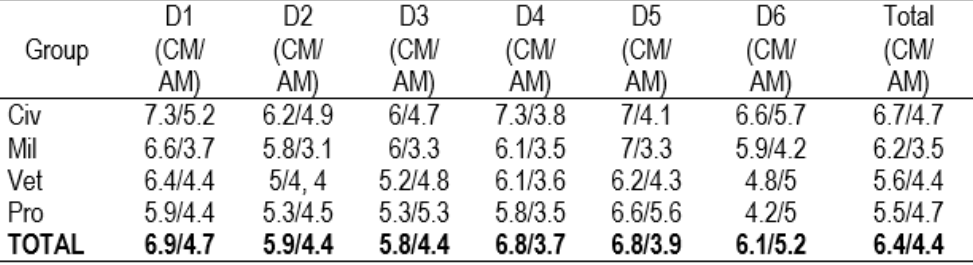
Table 3 Distribution of the results of the CM & AM reception broken down by source domains and groups of